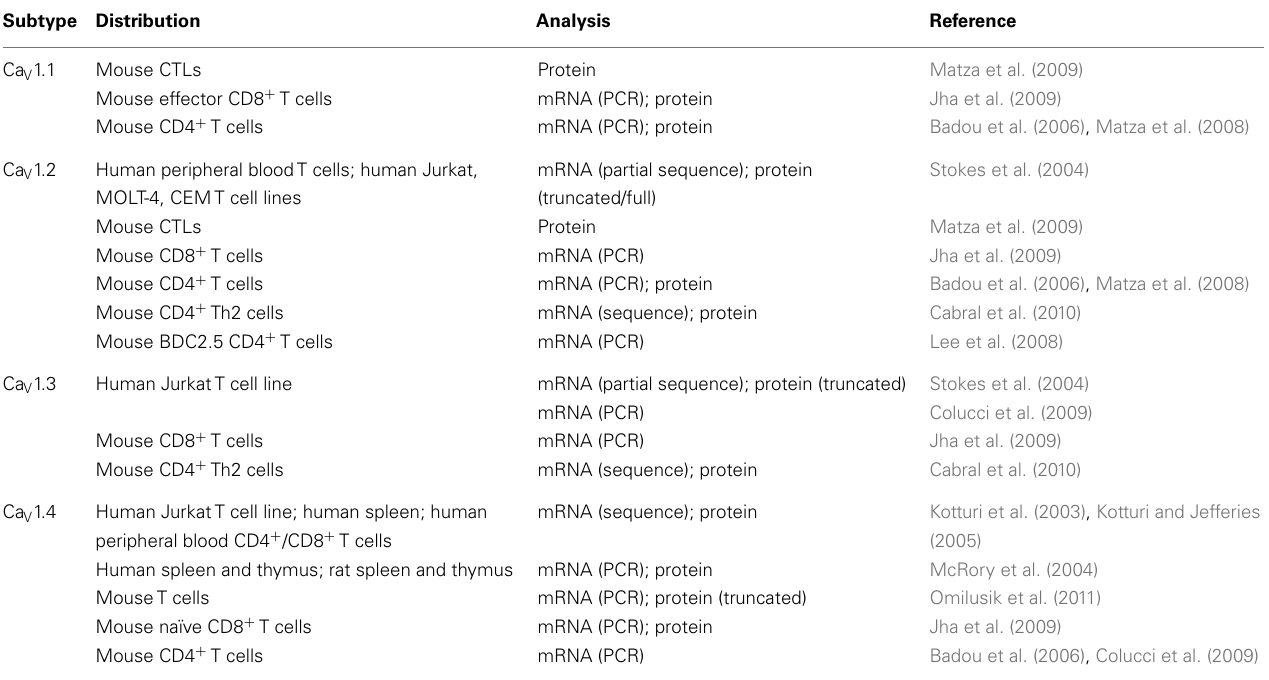
Table 1 | Ca V 1 Ca 2 + channel expression inT